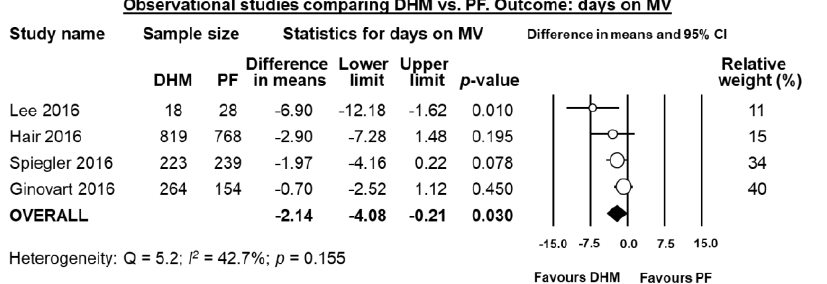
Figure 5. Meta-analysis of observational studies assessing the effects of supplementation of MOM with DHM, compared with supplementation with PF, on mean days on mechanical ventilation. Circles (O) represent the effect sizes per study, and their size represents the relative weight of the study in the meta-analysis. Diamonds ( ◆ ) represent the pooled effect size. DHM: donor human milk; PF: preterm formula.